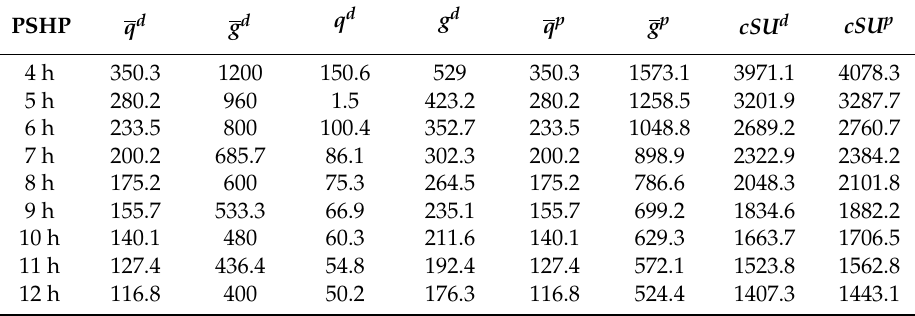
Table 1. Technical data of each PSHP. g refers to power, q refers to flow and cSU refers to start-up cost. Superscript d refers to generating mode and p refers to pumping mode. Flows are expressed in m 3 /s, power in MW and start-up costs in €